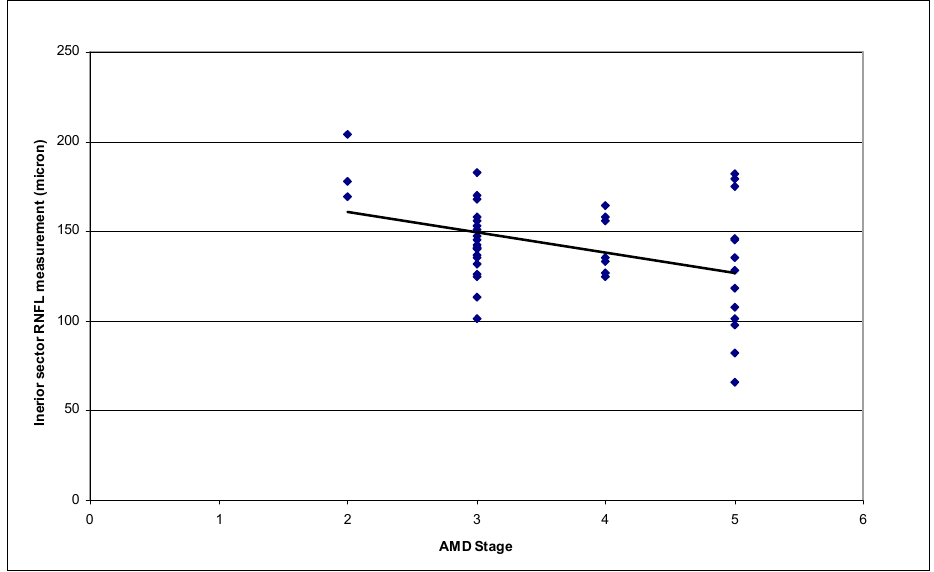
Figure 3. Correlation between inferior sector RNFL measurements by Spectral-domain OCT and AMD stages. ( p = 0.015, R 2 = 0.157; OCT: Optical coherence tomography; AMD: Age-related macular degeneration; RNFL: Retinal nerve fiber layer.).